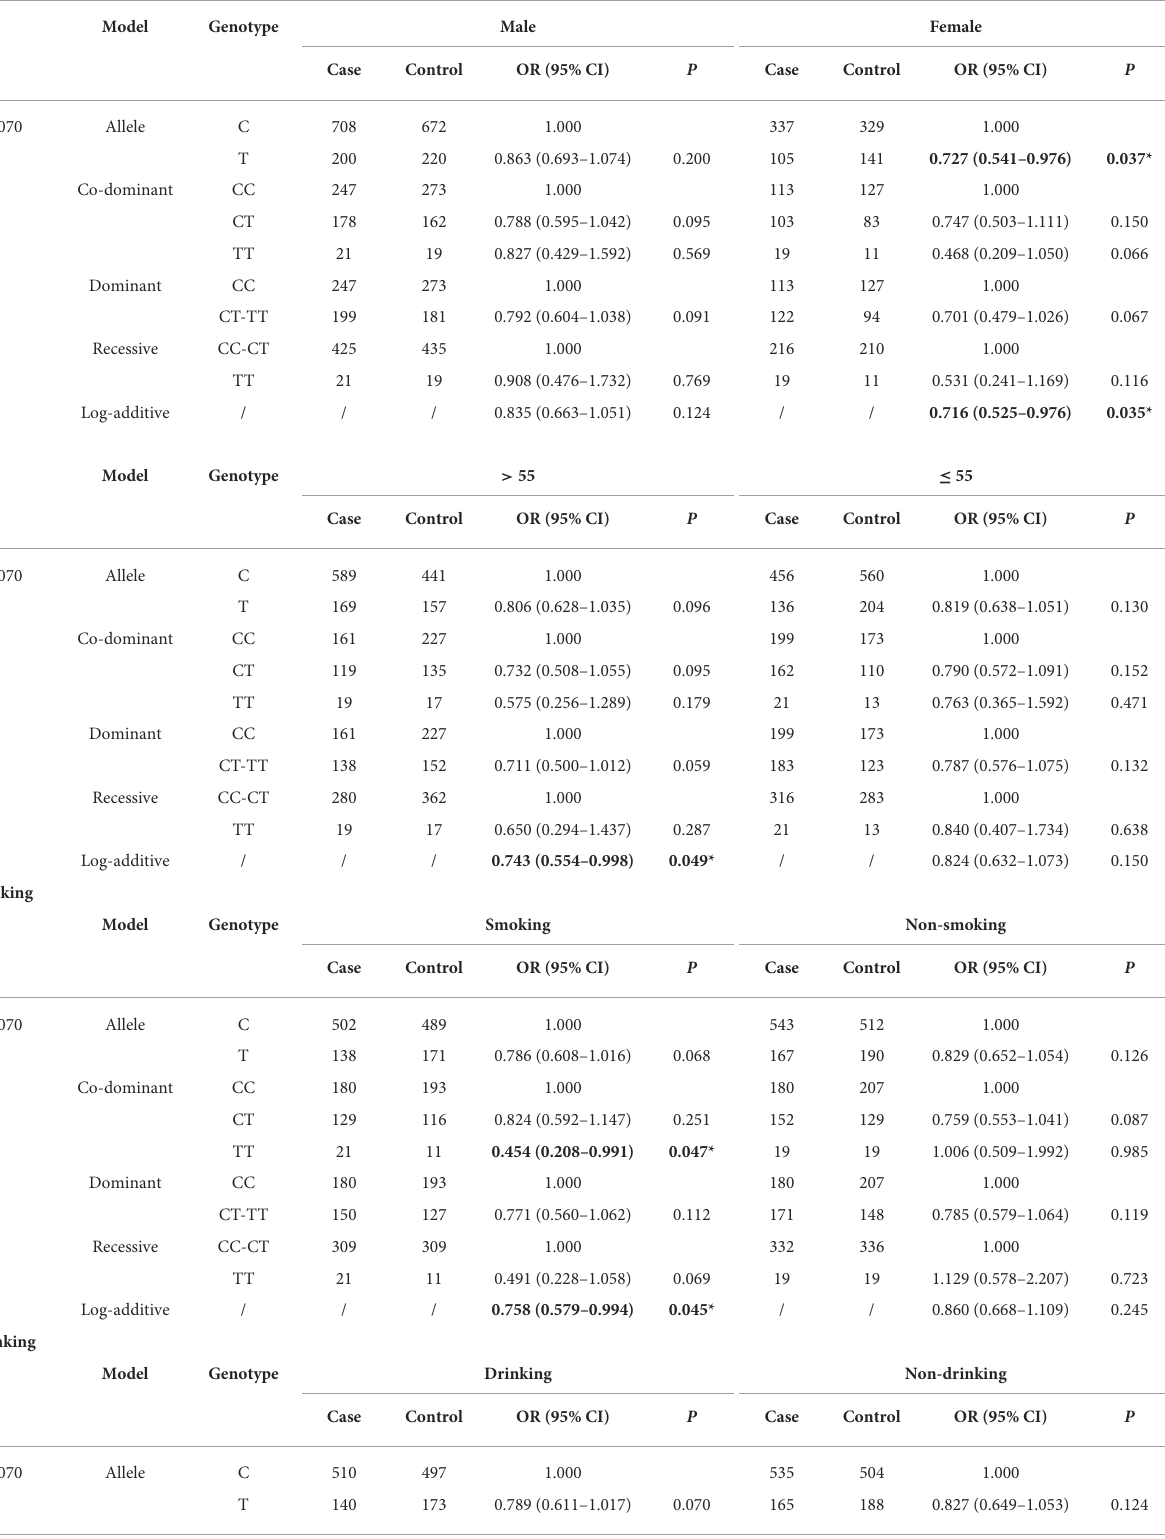
TABLE 5 Relationship between rs14070 of MMP2 and ischemic stroke in different